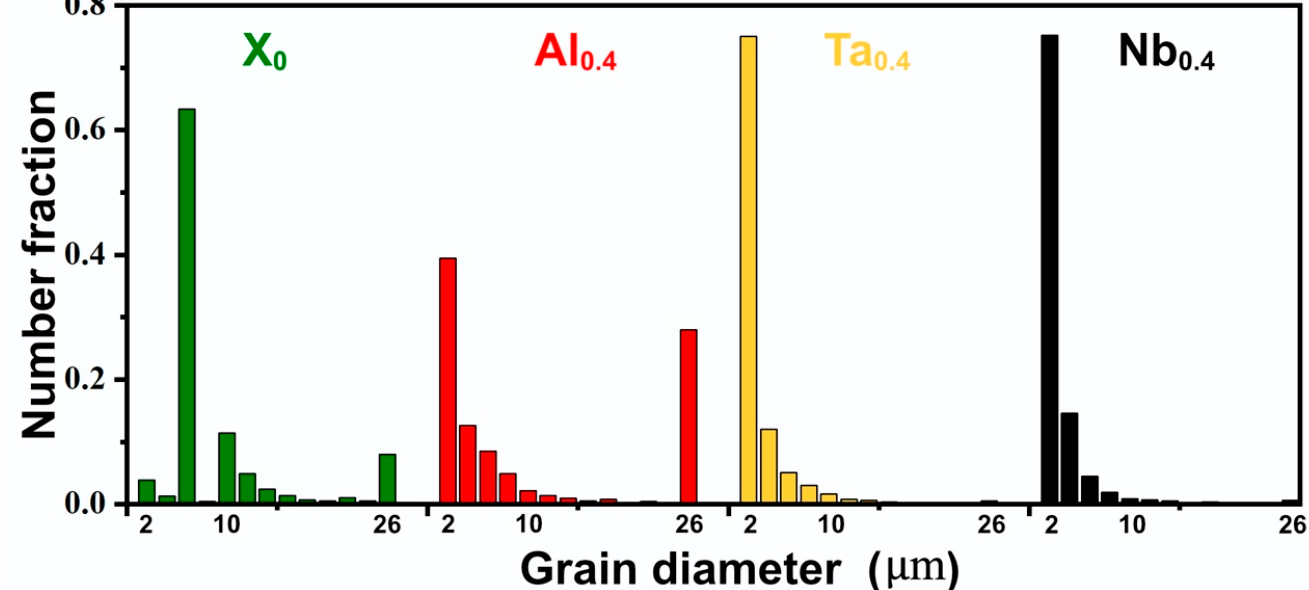
Figure 7. Grain size distribution of the CoCrFeNiX 0.4 (X = Al, Ta, Nb) HEAs prepared by PPA-AM.